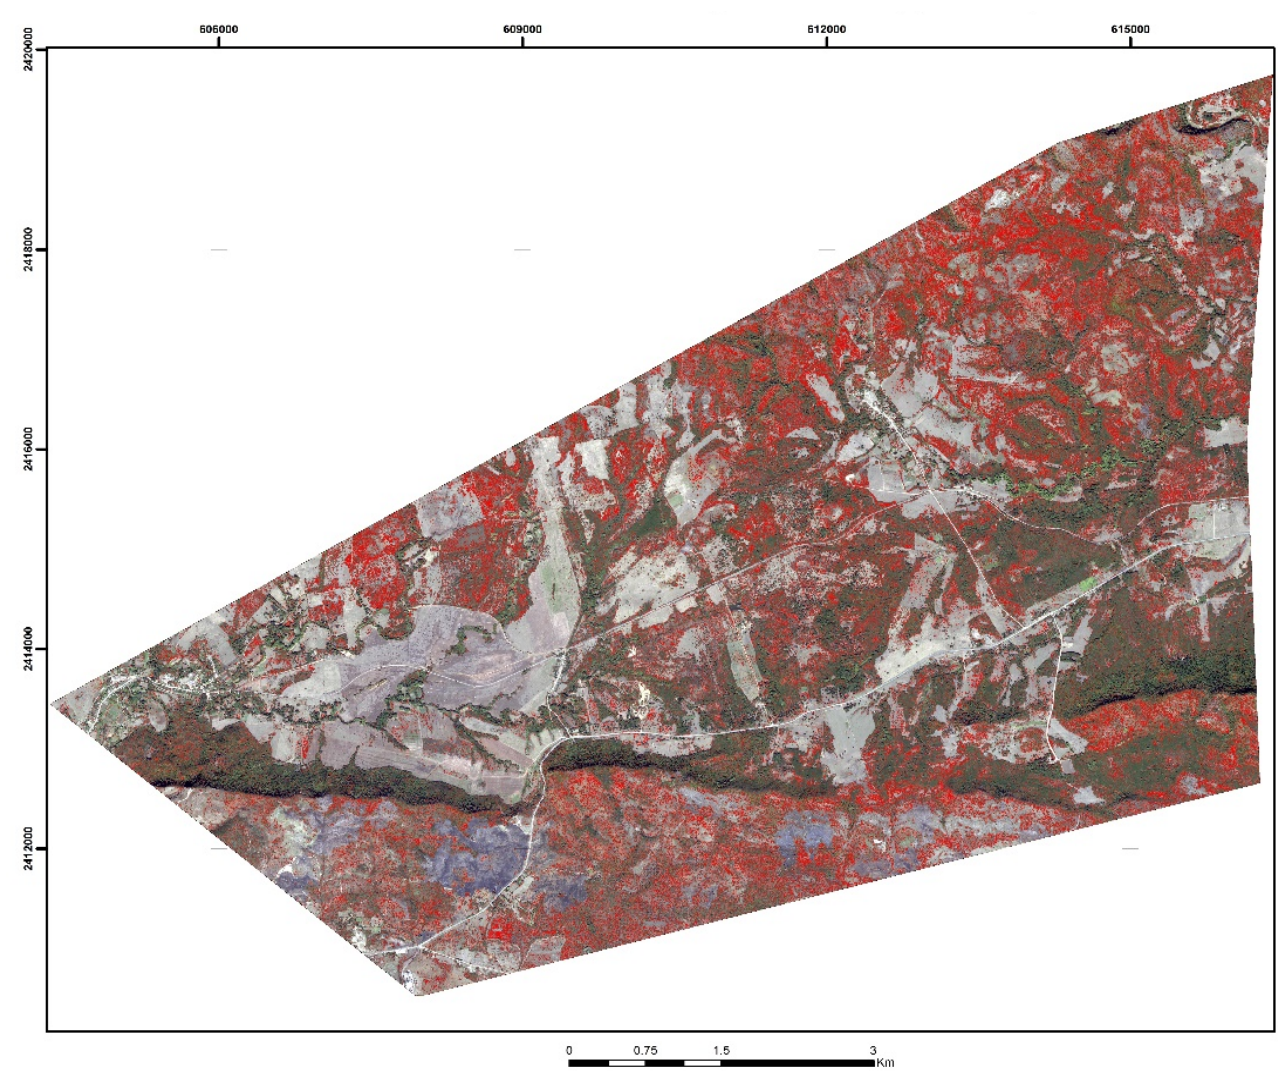
Figure 3. Spatial distribution of sicklebush (shown in red) based on the maximum likelihood classification method in a WorldView-2 image of Trinidad-Valle de los Ingenios, Cuba. Datum: WGS1984; Spatial reference: UTM zone 17N; Latitude of origin: 0; Scale factor: 0.9996; Central meridian: − 81; False northing: 0; False easting: 500,000.